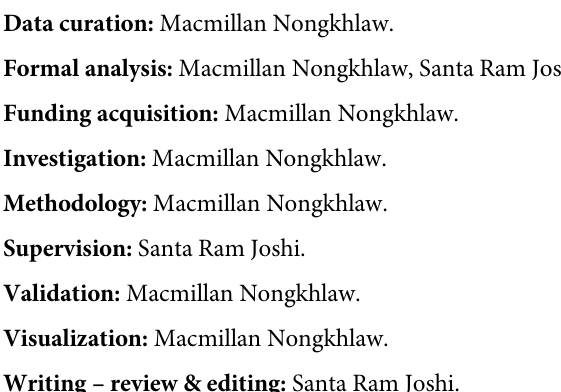
S1 Table. List of primers used for screening metal tolerant genes in Chrysobacterium sp.